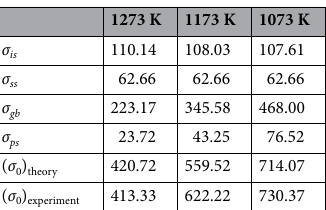
1273 K 1173 K 1073 K